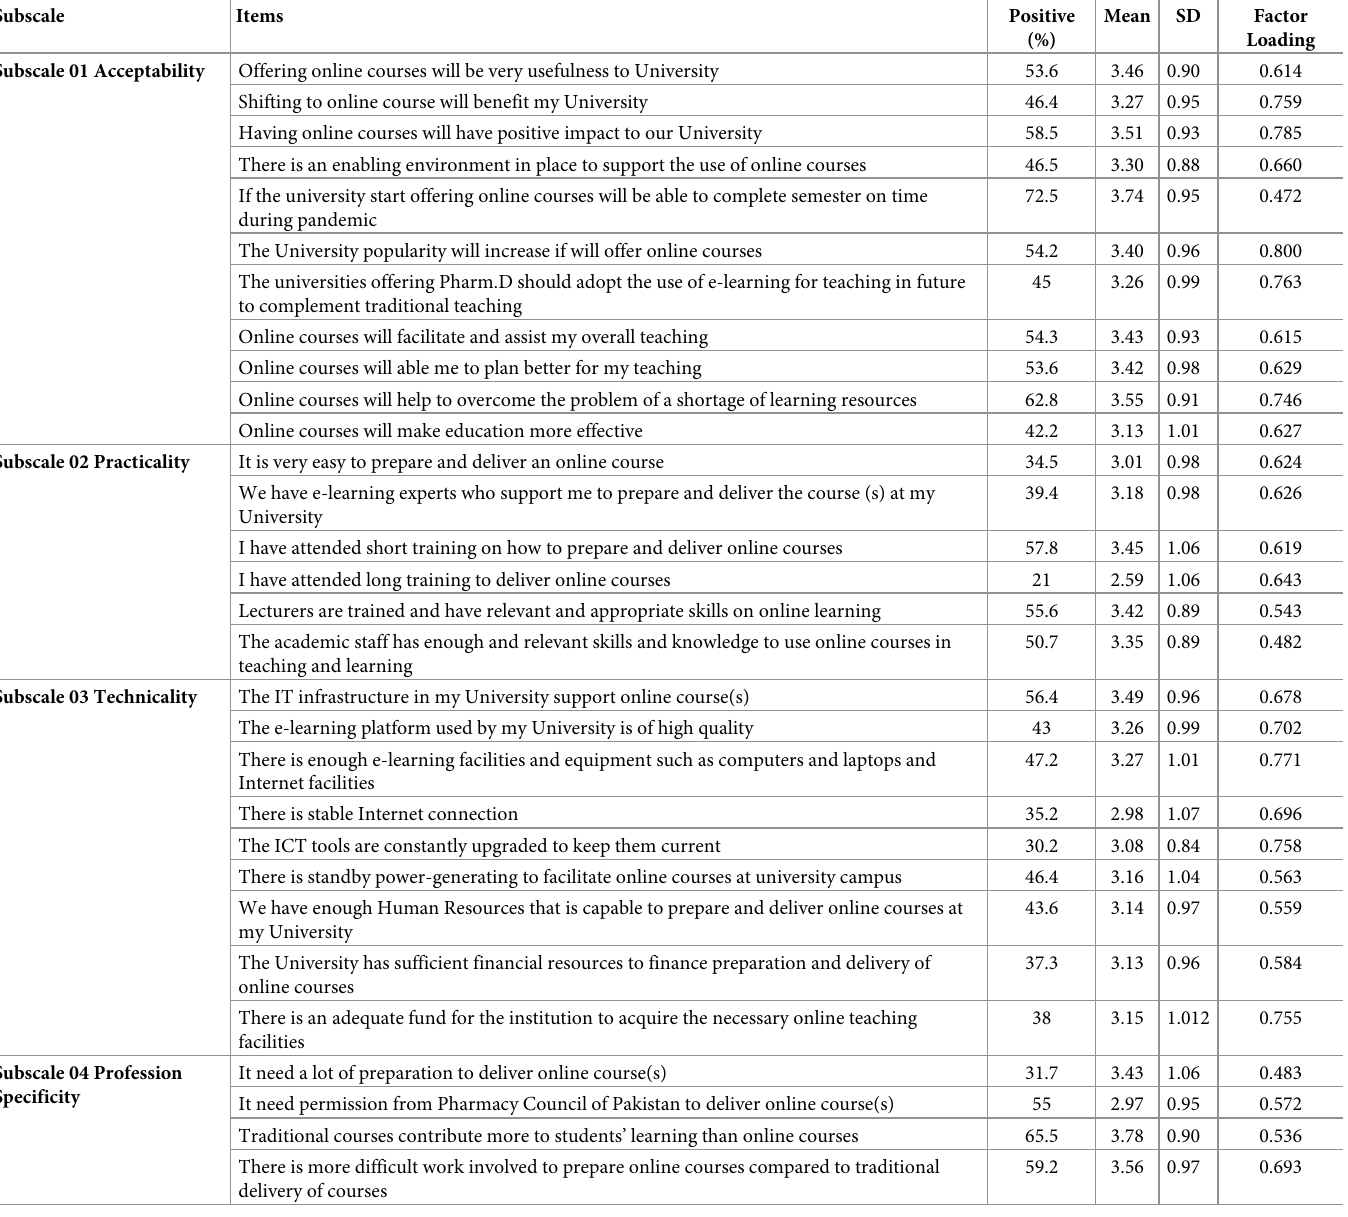
Table 3. Results of principal component analysis and pharmacy faculty responses. Subscale